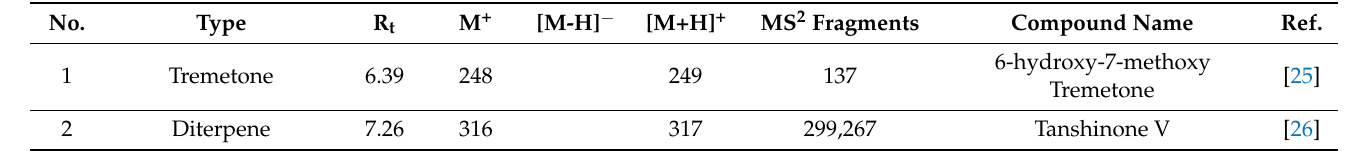
Table 2. Tentatively identified compounds in the dichloromethane fraction of S. hispanica L. aerial